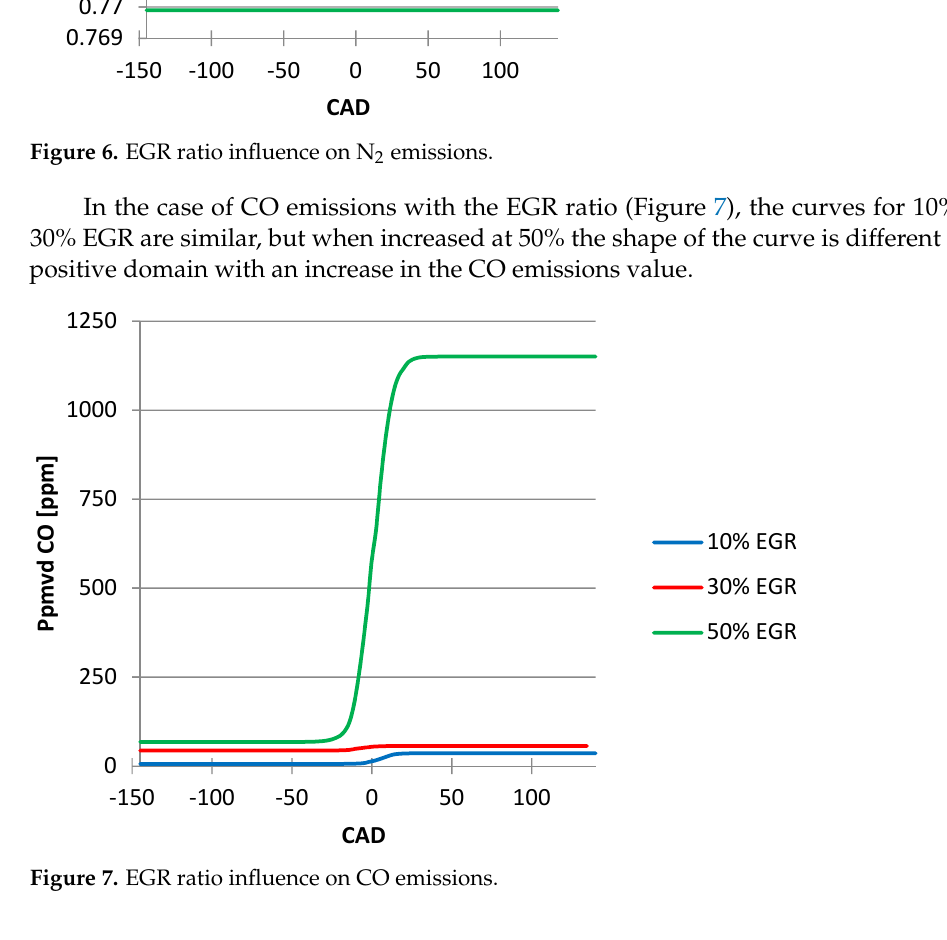
Figure 8. EGR ratio influence on UHC emissions. After comparing the CO emissions obtained with the help of the simulation program (1150 ppm) with those obtained in the experimental tests (1050 ppm) when we used the same input parameters, we can conclude that the simulation program is a good tool for determining the HCCI combustion characteristics. One explanation for the obtained difference is that in the simulation program we used a gasoline surrogate because gasoline has a too complex composition in order to be simulated. The methodological novelty of this research is building the experimental engine to optimize the HCCI phenomenon in order to combat the negative health effects on the population at large. With this engine, we can modify/adjust: the compression ratio; EGR gas flow; fine level of fuel adjustment; fresh air and EGR gases mixture adjustment; fresh air, EGR gases mixture, and fuel adjustment.